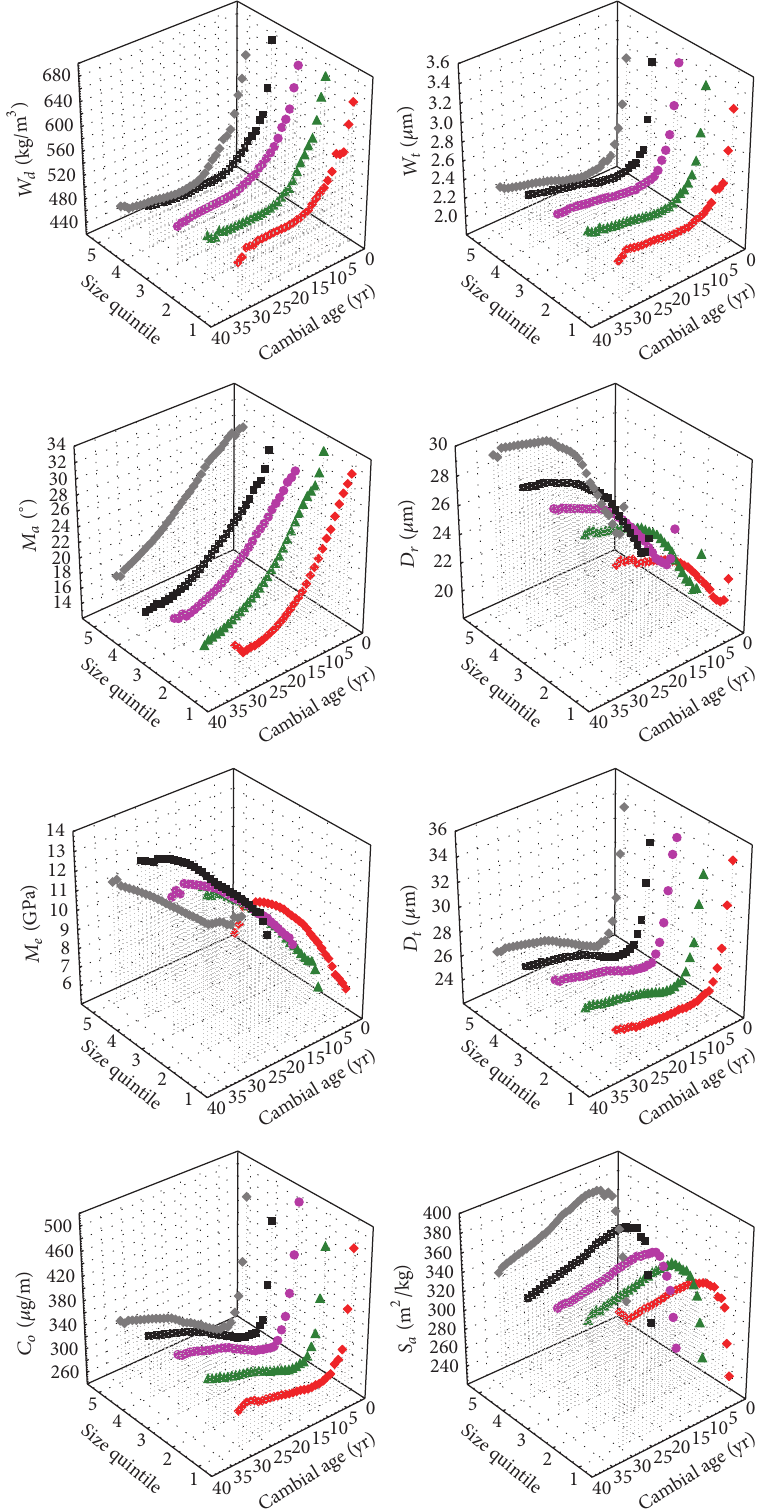
Figure 2: Three-dimensional visualization of mean temporal developmental trends illustrating patterns of change in attribute-specific cumulative area-weighted moving average values with increasing cambial age and size quintile. Note: 𝑊 𝑑 , 𝑀 𝑎 , 𝑀 𝑒 , 𝐶 𝑜 , 𝑊 𝑡 , 𝐷 𝑟 , 𝐷 𝑡 , and 𝑆 𝑎 denote the mean value up to the 𝑖 th cambial age for wood density, microfibril angle, modulus of elasticity, fibre coarseness, tracheid wall thickness, radial tracheid diameter, tangential tracheid diameter, and specific surface area,